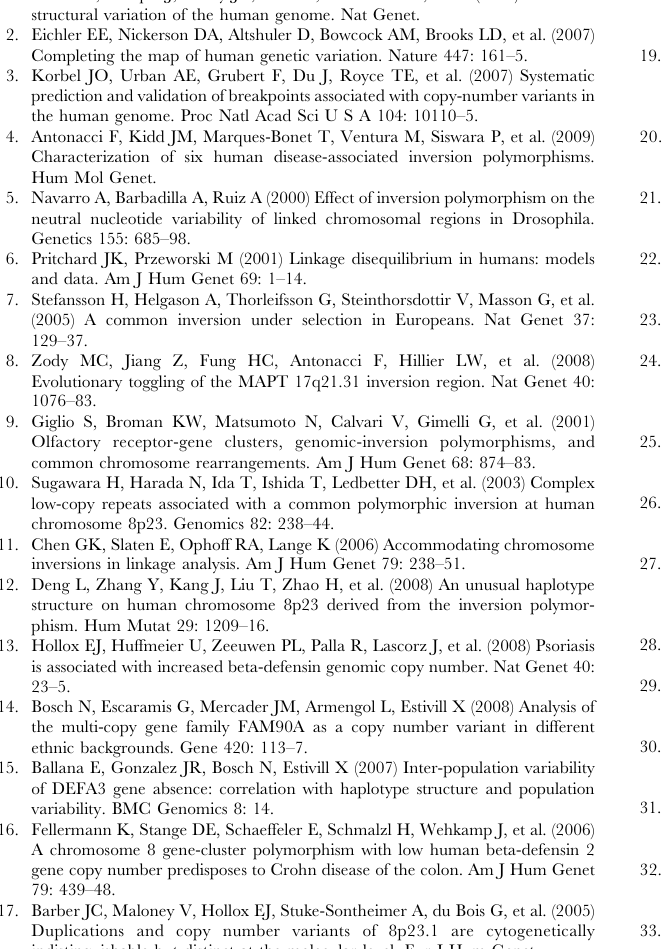
Table S2 8p23.1 Gene expression levels. Genes analyzed in the association study between gene expression levels and the genotype for the 8p23.1 inversion, and their corresponding probes